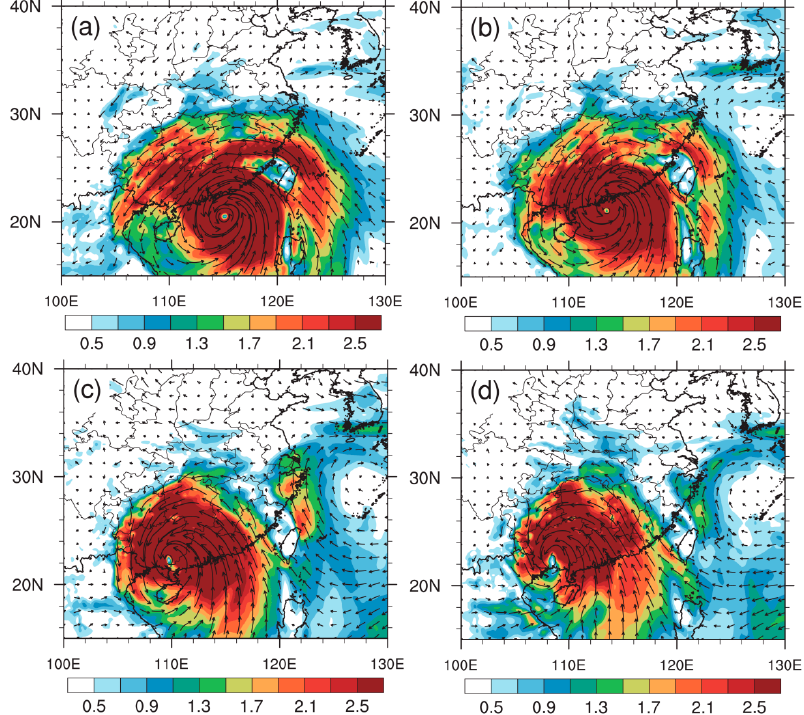
Figure 3. Moisture transport (10 − 1 g m − 1 s − 1 hPa − 1 ) at 850 hPa at ( a ) 0000 UTC 16 September, ( b ) 0600 UTC 16 September, ( c ) 1800 UTC 16 September, and ( d ) 0000 UTC 17 September 2018.